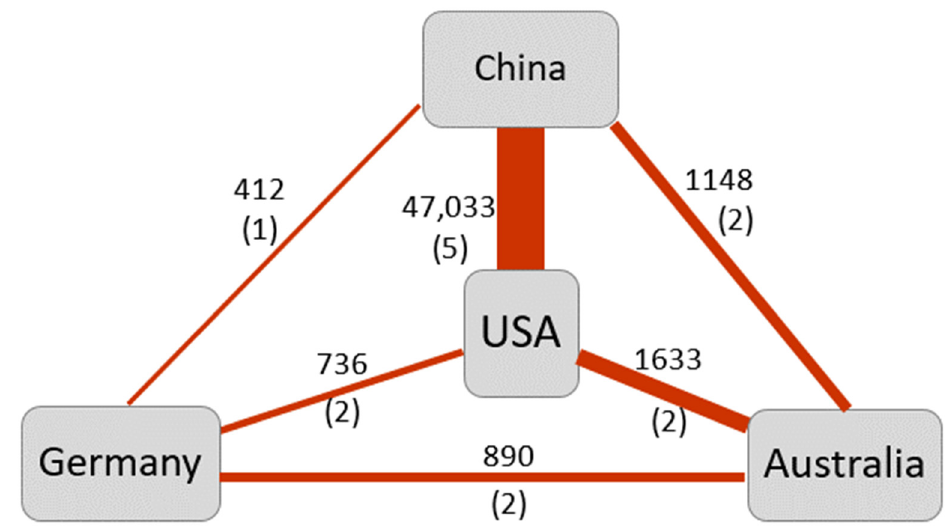
Figure 7. Role of individual countries in bilateral scientific cooperation publications.